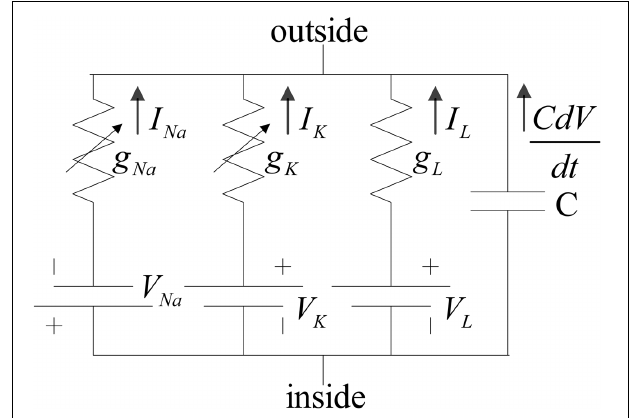
FIGURE 1 | Hodgkin and Huxley proposed circuit for squid giant axon.